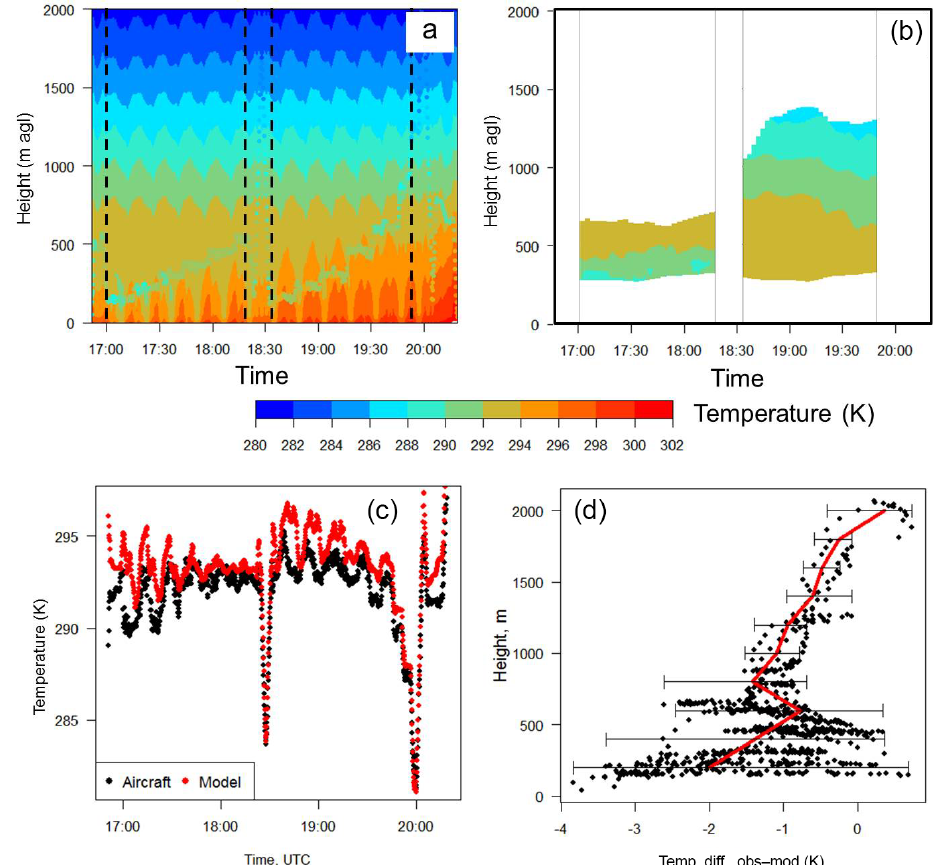
Figure 9. Model versus observed temperatures, flight 12. (a) Background model-predicted temperature profiles with observed temperatures overlaid (dots) with the same colour scale. (b) Observed temperatures along the portion of the transect containing the plumes, between 17:00 and 18:18 and between 18:32 and 19:45UTC. (c) Model (red) and observed (black) temperatures as a function of time; (d) temperature deviation (observations – model) as a function of height, with the red line showing the mean deviation at every